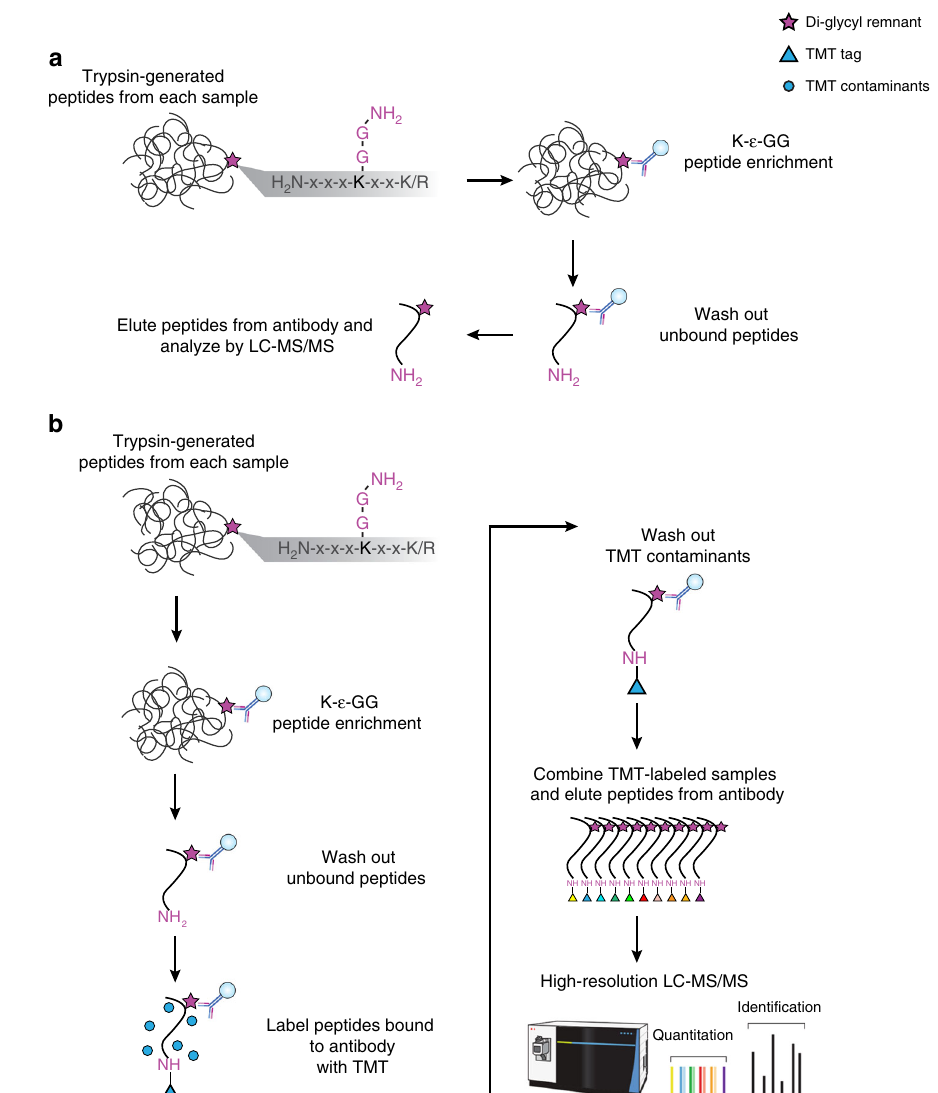
Fig. 1 Comparison of methods for multiplexed ubiquitylome analysis. a Conventional work fl ow for an anti-K- ɛ -GG antibody-based enrichment without isobaric labeling, where the antibody recognizes primary amine containing K- ɛ -GG epitope. b UbiFast work fl ow employing on-antibody labeling with isobaric mass tag reagents (e.g., TMT10/11) for anti-K- ɛ -GG antibody-based enrichment of ubiquitylated